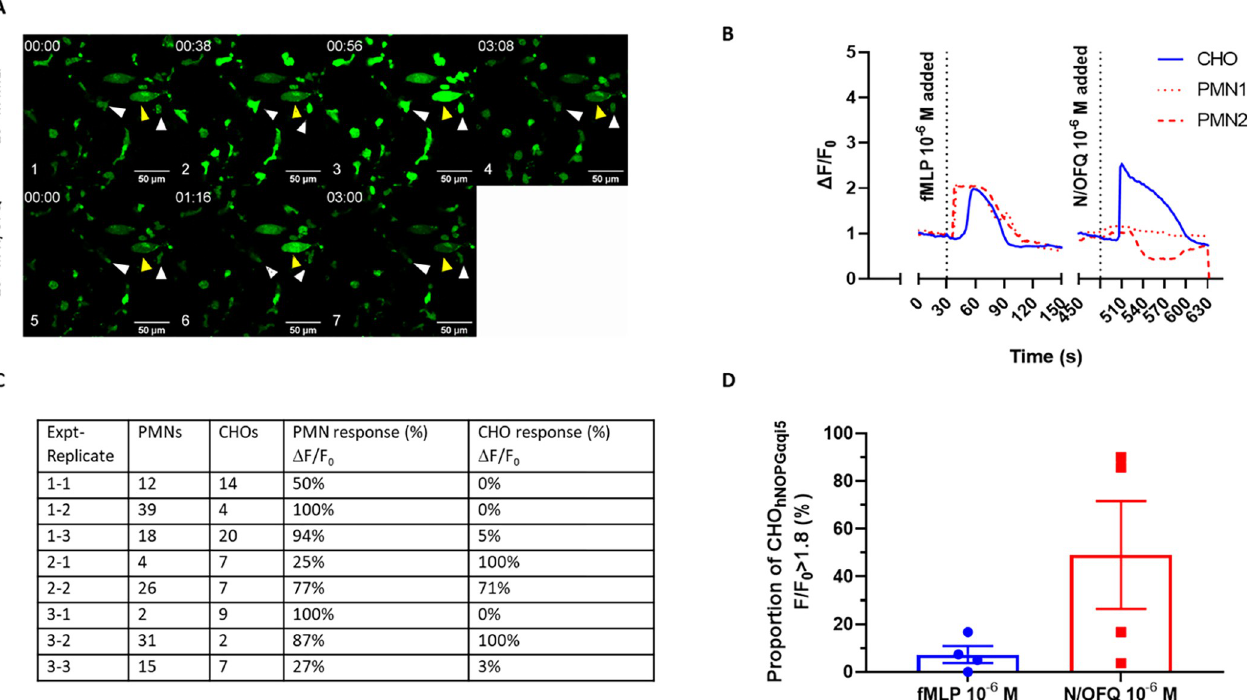
Fig 4. Responses of CHO hNOPG α qi5 to 10 -5 M fMLP and 10 -6 M N/OFQ. A . Representative change in Δ F/F 0 of CHO with colayered PMNs in response to exposure to 1 x10 -6 M fMLP (1–4) and 1 x10 -6 M N/OFQ (5–8) as measured by confocal microscopy using FLUO-4 as an indicator dye. Basal 1, 5; maximal PMN, 2; maximal CHO 3, 6; return to basal, 4, 7). PMNs are identified by white arrows, while CHOhNOP G α qi5 are identified by yellow arrows. B . Representative single experiment showing change in Δ F/F 0 of CHO cells with colayered PMNs in response to exposure to 1 x10 -6 M fMLP, washing and 1 x10 -6 M N/OFQ as measured by confocal microscopy using FLUO-4 as an indicator dye. C . Proportion of colayered PMN and CHO cells responsive following exposure to 1 x10 -6 M fMLP. D . Combined CHO cellular responses following exposure of colayered PMNs to 1 x10 -6 M fMLP, washing and then 1 x10 -6 M N/ OFQ. Error bars show SEM (n =